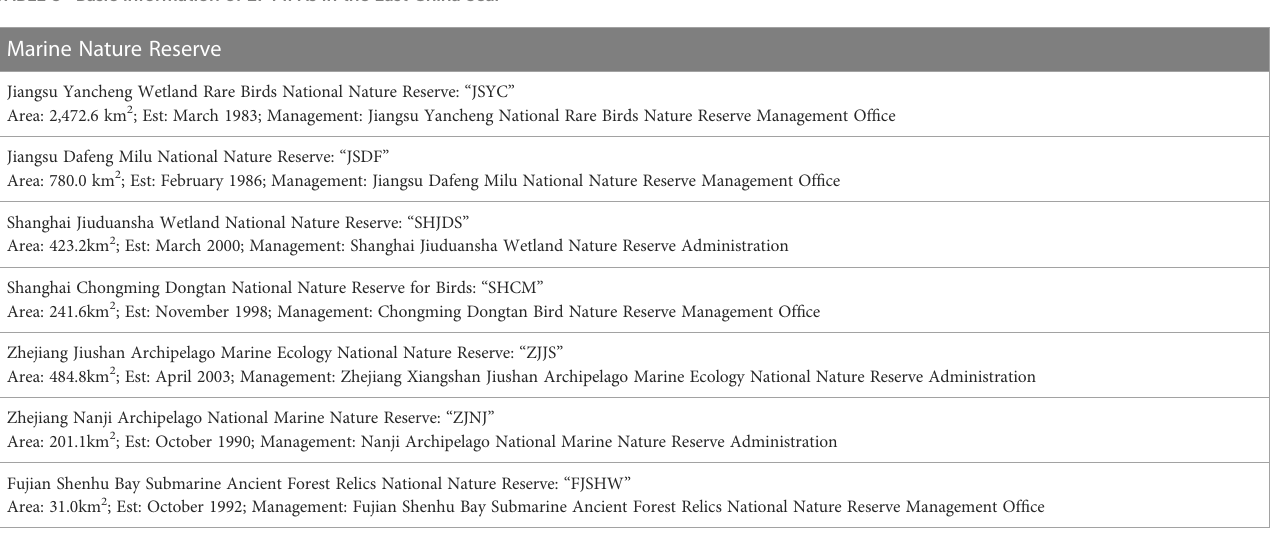
TABLE 3 Basic information of 27 MPAs in the East China